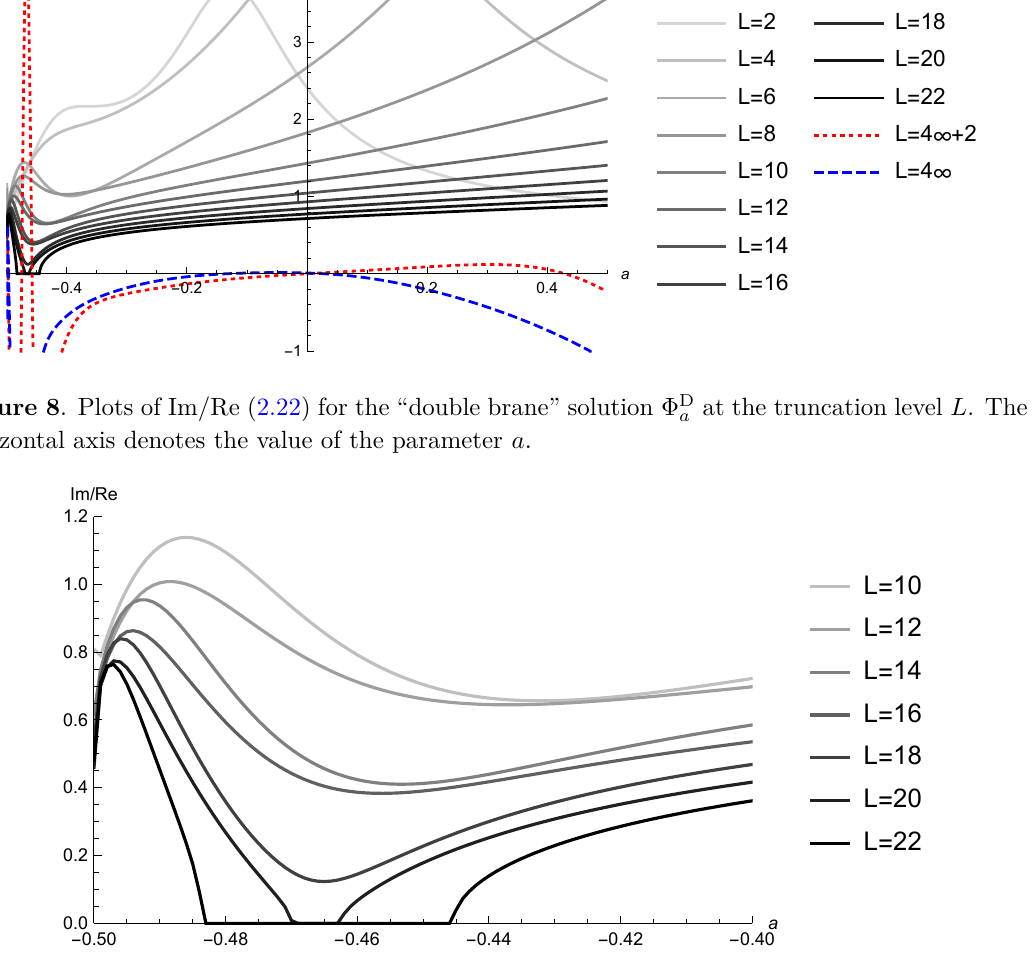
such as a & − 1 / 2 at the a